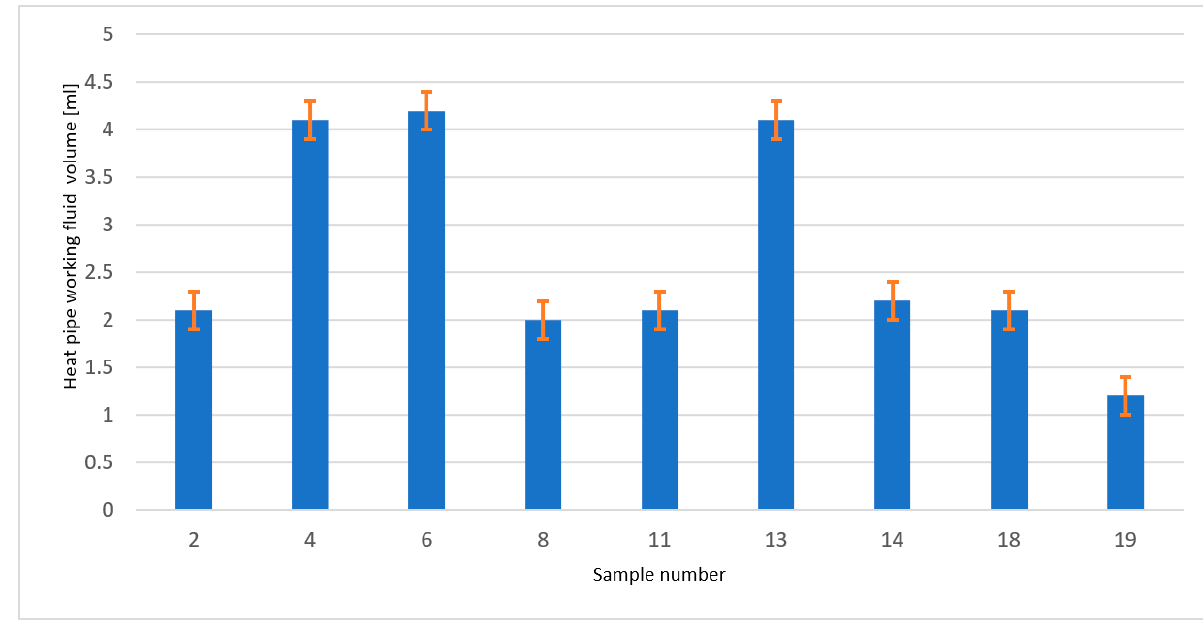
Figure 18. Results of the working medium volume measurements in the heat pipes.